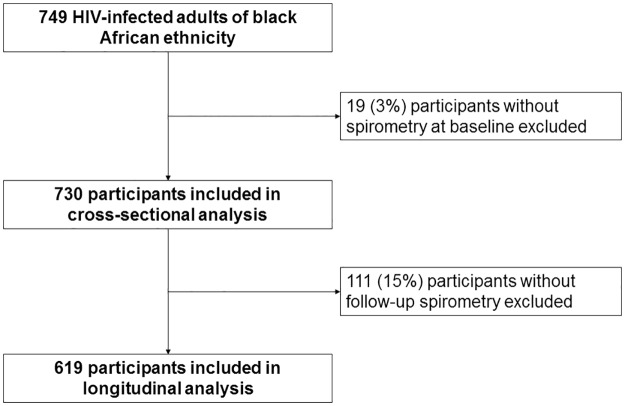
Consort diagram describing participant recruitment, exclusions and analytic sample sizes.